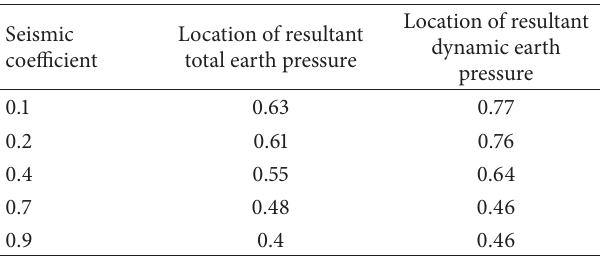
Table 3: Location of resultant earth pressure of road shoulder retaining wall on soil foundation ( ℎ / 𝐻 ).